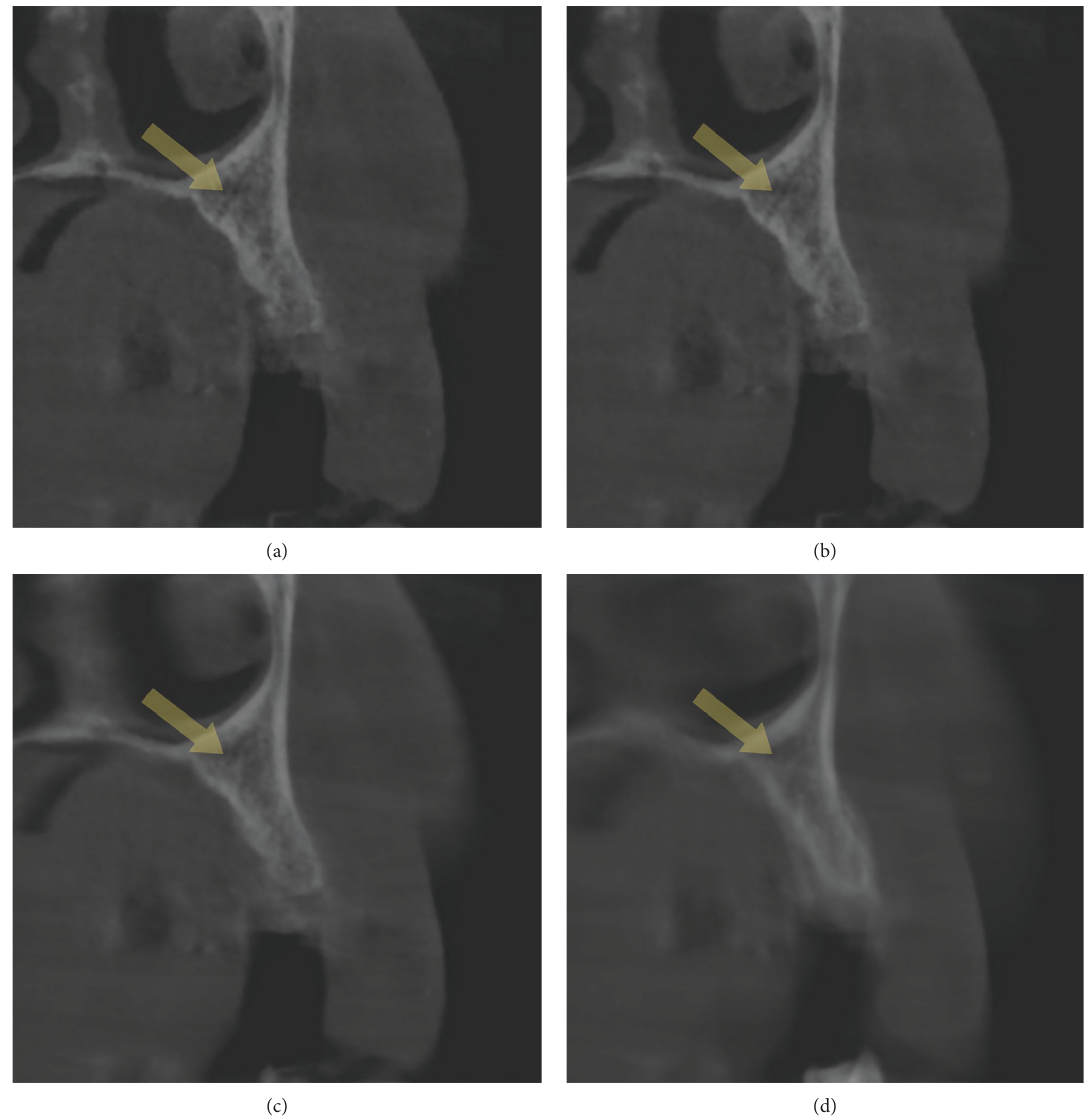
Figure 1: CS with different slice thicknesses in the same patient: (a) 0.5mm, (b) 1mm, (c) 3mm, and (d) 10 mm. Note that CS is almost visualized with 3 mm and 10 mm slice thicknesses.